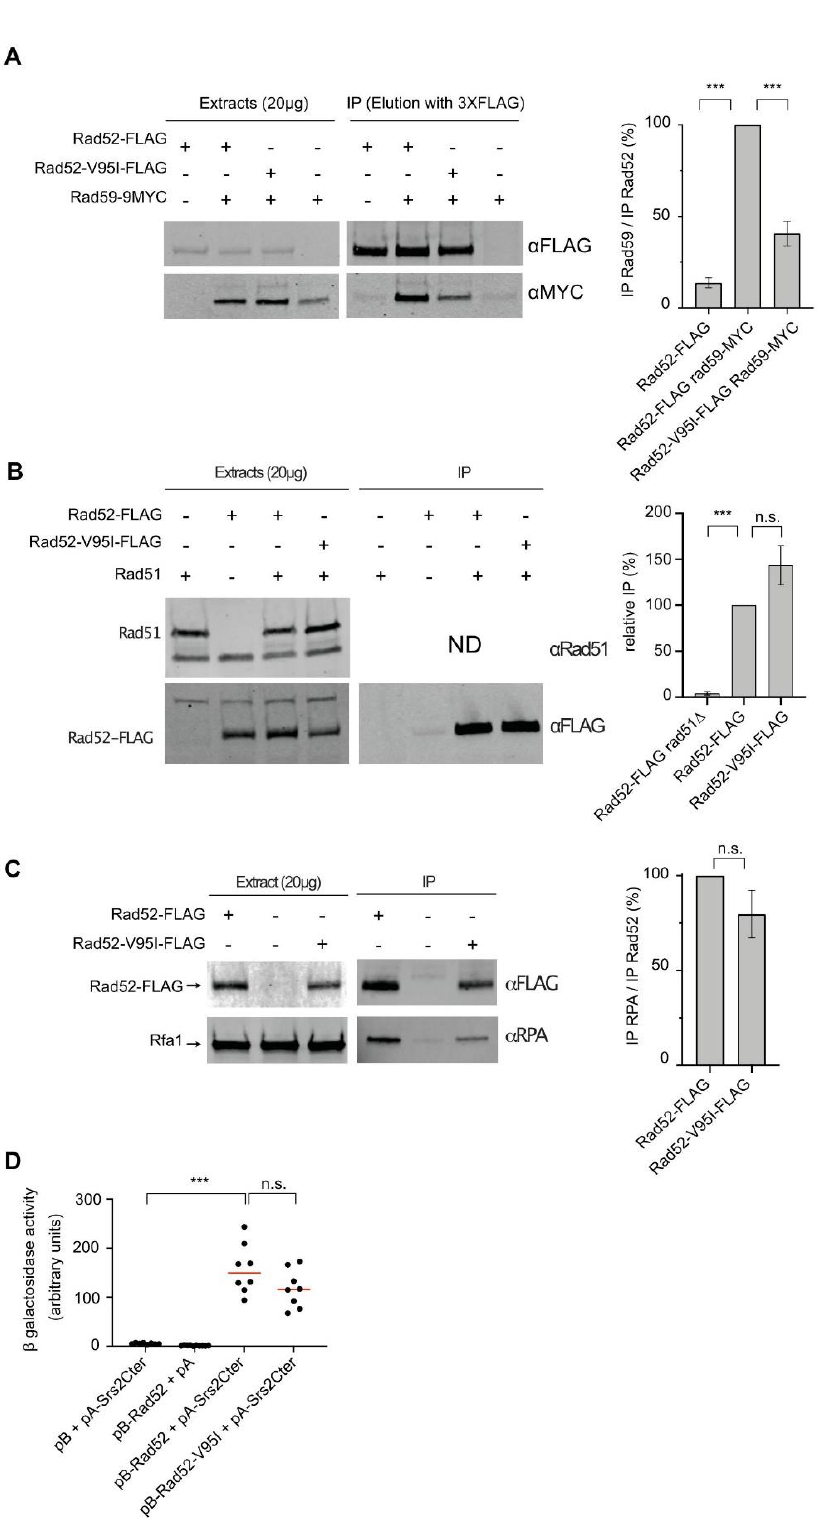
Figure 7 . Impact of V95I on Rad52–FLAG interaction with partner proteins. ( A ) Analysis of Rad52- FLAG–Rad59–MYC interaction by co-immunoprecipitation. Rad52-FLAG was precipitated with an anti-FLAG antibody from whole cell extracts. Proteins bound to the antibody were specifically eluted with a 3XFLAG peptide, to avoid the recovery of the anti-FLAG antibody in the immuno- precipitated fraction, because Rad59-MYC migrates at the same level as the anti-FLAG antibody. Rad52-FLAG and Rad59-MYC were detected in whole cell extracts and in the immunoprecipitated fraction (IP) with anti-FLAG and -MYC antibodies, respectively. The histogram shows the ratio between the Rad59 signal relative to the Rad52 signal in the immunoprecipitated fraction (mean ±